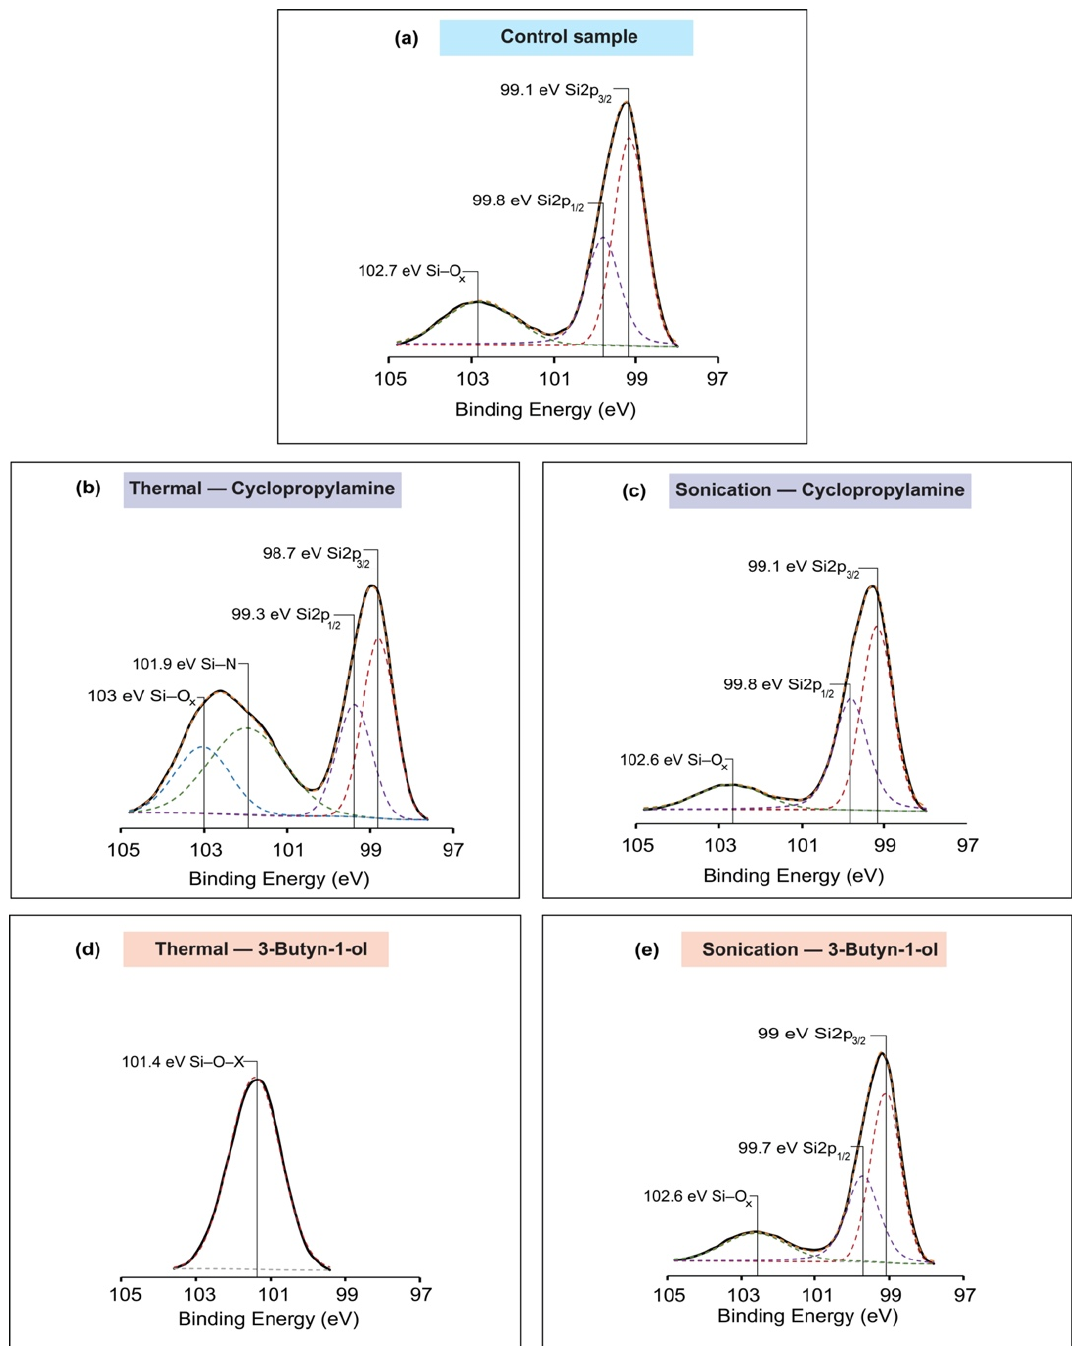
Figure 2. Si2p spectrum deconvolution for ( a ) control sample; ( b ) cyclopropylamine thermal excitation. A silicon nitrogen peak appeared at 101.9 eV; ( c ) cyclopropylamine sonochemical reaction; ( d ) 3-Butyn-1-ol thermal excitation with a single peak fitted at 101.4 eV; ( e ) 3-Butyn-1-ol sonochemical reaction.